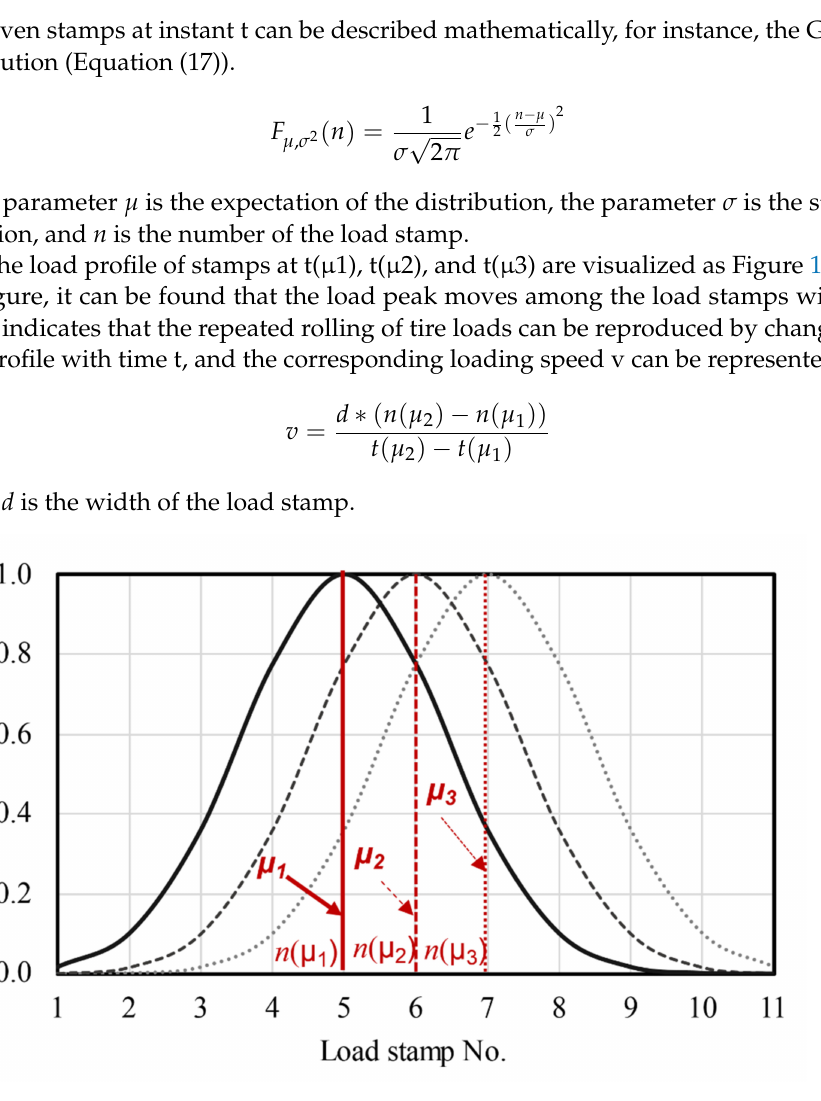
Figure 13. Load profile of stamps with different µ